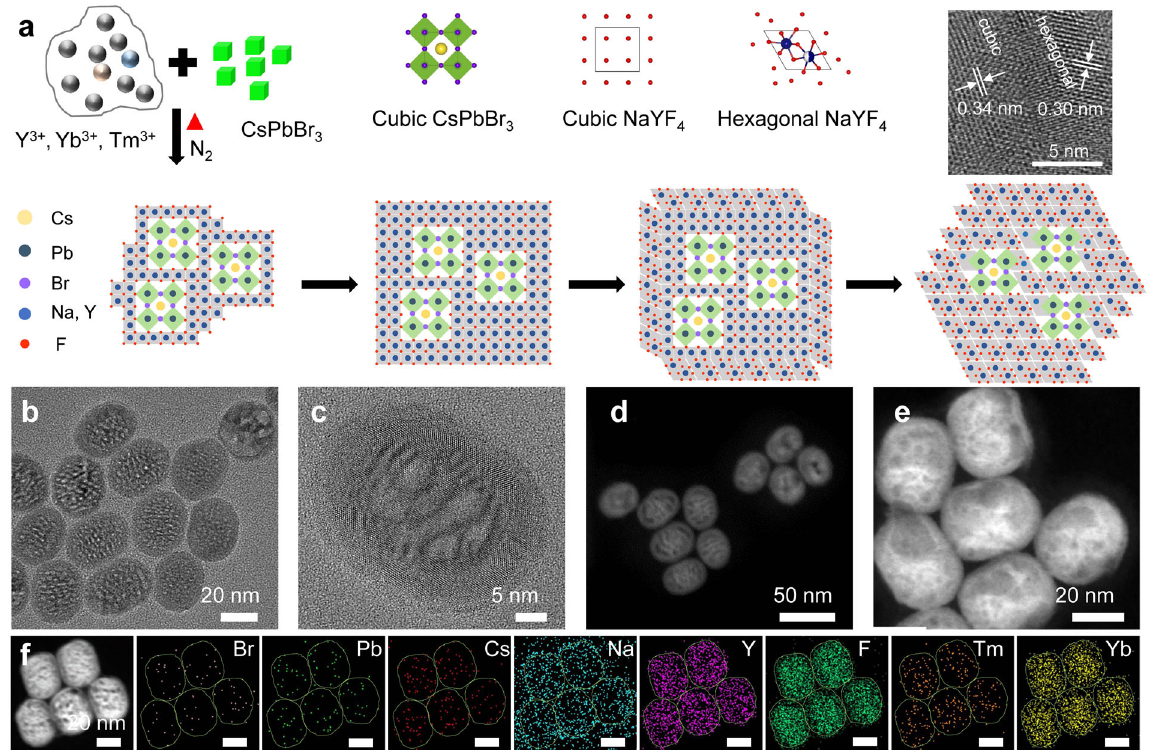
Fig. 1 Synthesis of CsPbBr 3 -NaYF 4 :Yb,Tm hybrid nanocrystals. a Schematic showing the formation of heterostructured CsPbBr 3 – NaYF 4 : Yb,Tm nanocrystals, b , c TEM and d , e STEM images of heterostructured CsPbBr 3 – NaYF 4 :Yb,Tm nanocrystals. f Elemental mapping of heterostructured CsPbBr 3 – NaYF 4 :Yb,Tm nanocrystals. Scale bars in f , 20